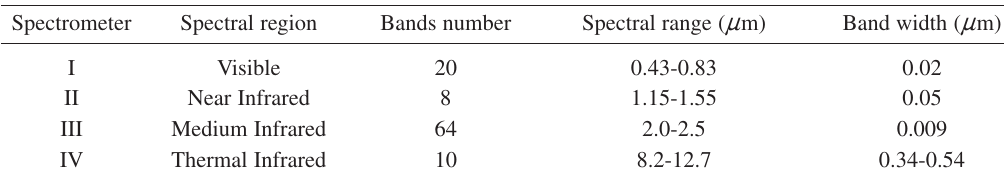
Table I. MIVIS spectral